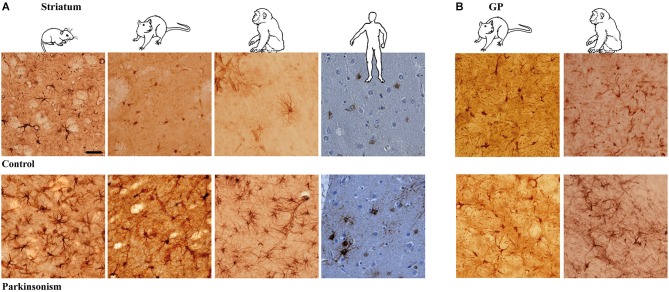
Astrocytic reaction to dopamine depletion in striatum and GP of animal models of PD and parkinsonian patients. Dopamine depletion increase GFAP-S100β immunolabeing in striatum (A) and GP (B) of reserpine mouse, 6-OHDA rat, MPTP non-human primate models of PD and PD patients (scale bar = 30 μm).